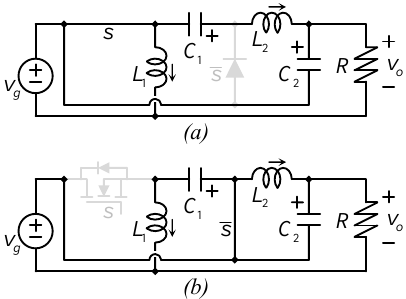
o v R Figure 7. The proposed improved super-boost ISB converter. From the circuit in Figure 7 and the defined polarities for voltages and currents, the output voltage and the input current are given by Equations (26) – (27). 2 o